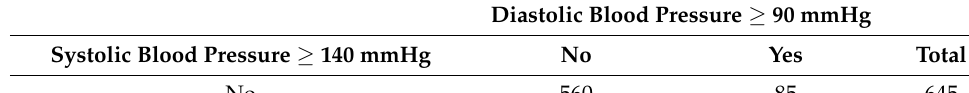
Table A1. Number with high systolic and diastolic blood pressure at age 45–49 years (Tromsø 2). The Tromsø Study